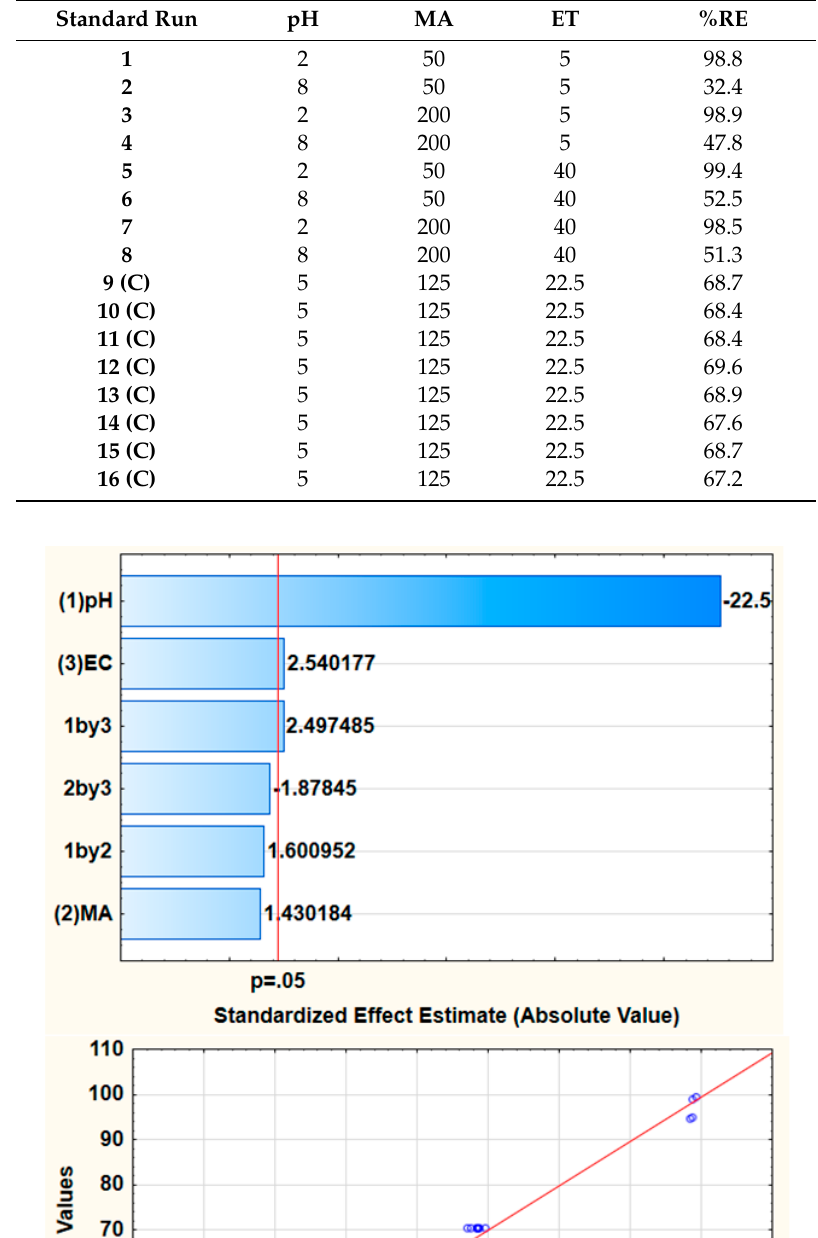
Table 1. FFD matrix of actual variable together with experimentally obtained analytical response (%RE).